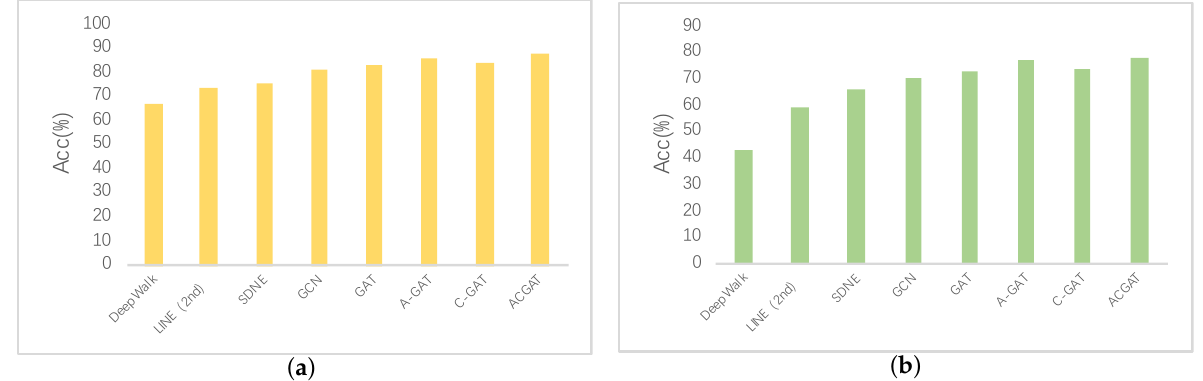
Figure 11. ( a ) Classification results for Cora. ( b ) Classification results for